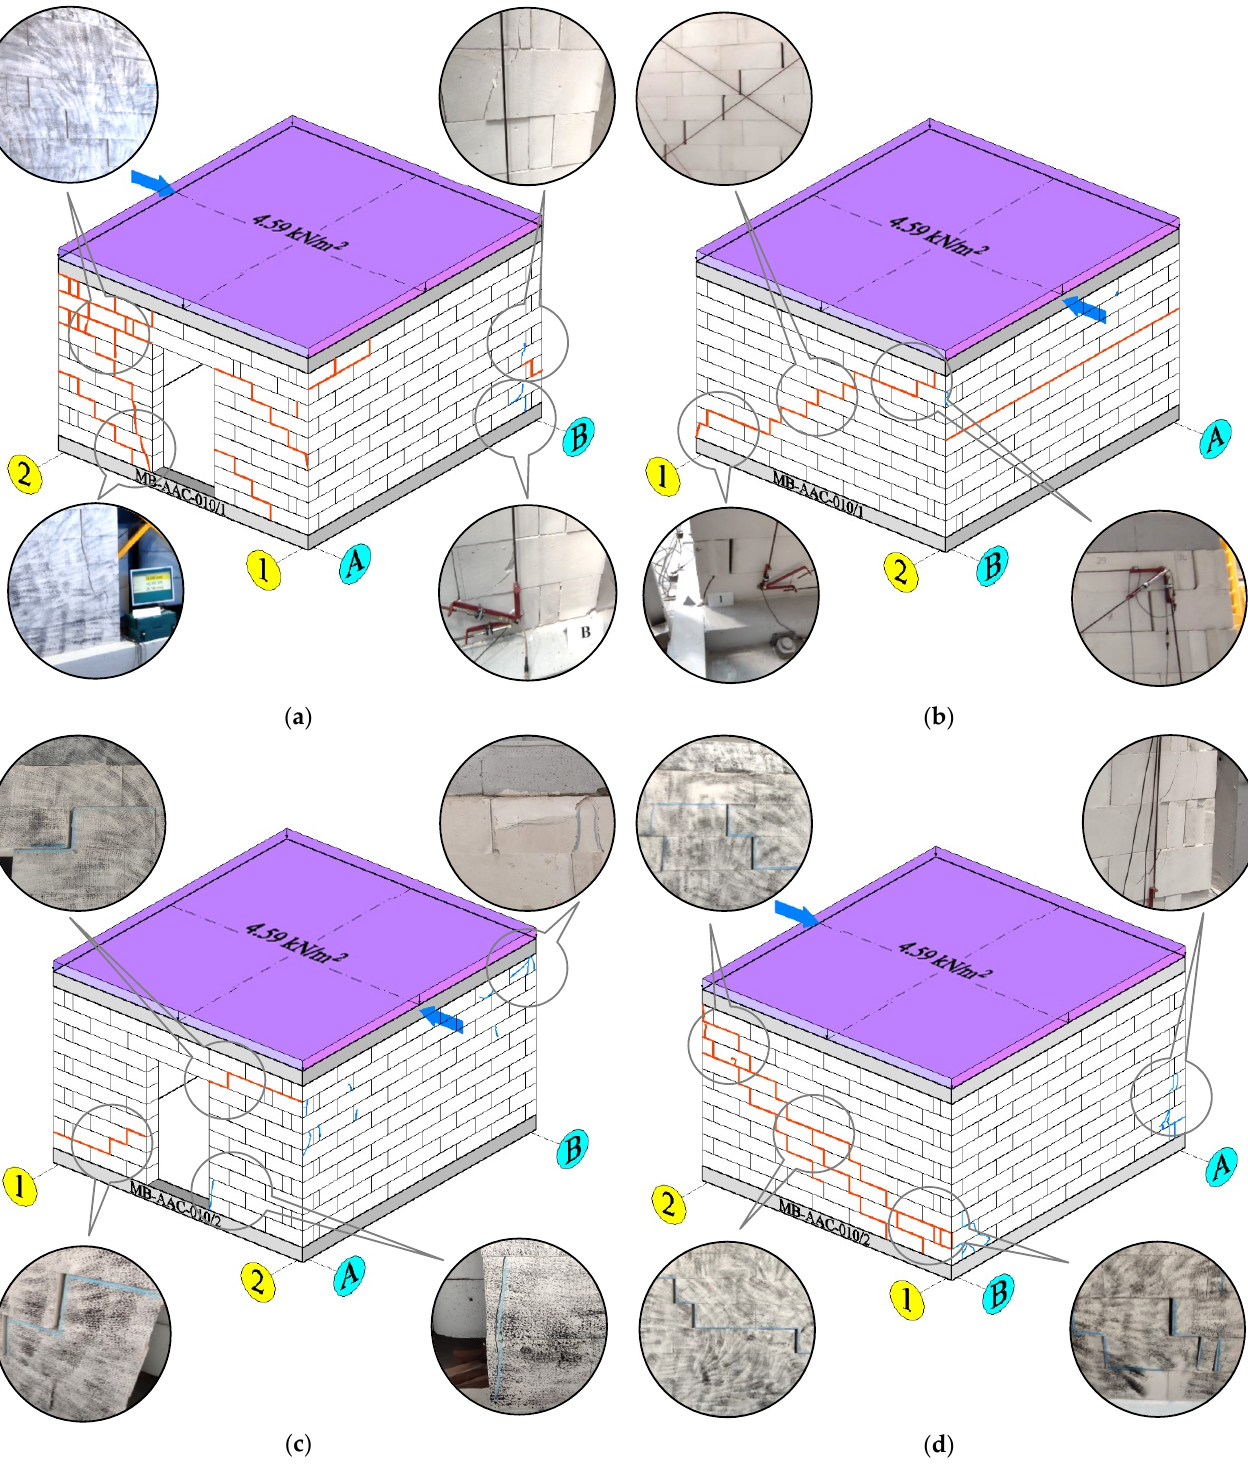
Figure 11. The crack pattern of tested masonry buildings; ( a ) front view of MW-AAC-010/1 model; ( b ) back view of MW-AAC-010/1 model; ( c ) front view of MW-AAC-010/2 model; ( d ) back view of MW-AAC-010/2 model; the blue arrow marks the horizontal